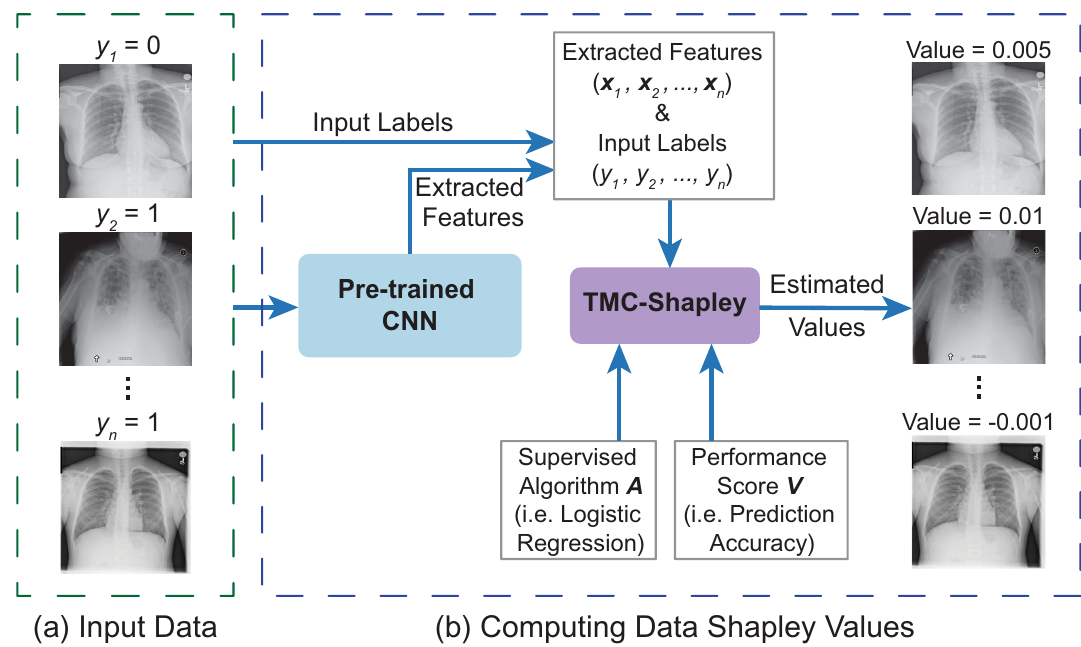
Figure 1. Overview of our method. ( a ) The input data were chest X-ray images and their corresponding labels (1 for pneumonia and 0 for no pneumonia) from ChestX-ray14 dataset 9 . ( b ) To compute data Shapley values for the training data, we first extracted feature vectors from a pre-trained convolutional neural network (CNN), CheXNet 36 . Next, we applied TMC-Shapley 17 to approximate the Shapley value of each training datum, where the supervised learning algorithm was logistic regression, and the predictor performance score was prediction accuracy for